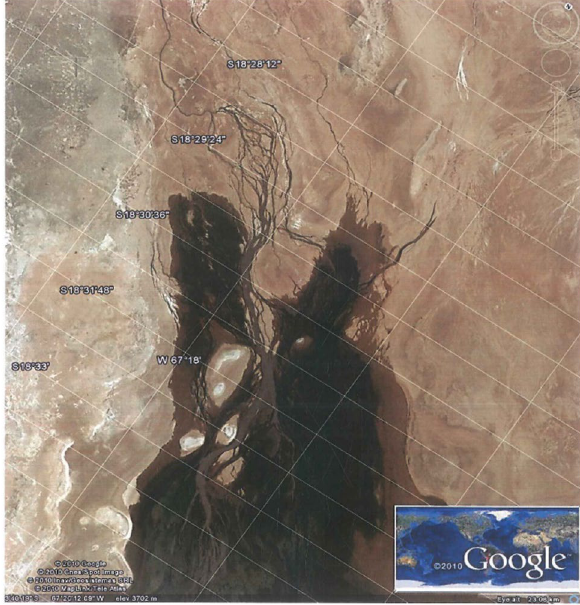
Fig. 5 Channel image recorded by seismic attribute